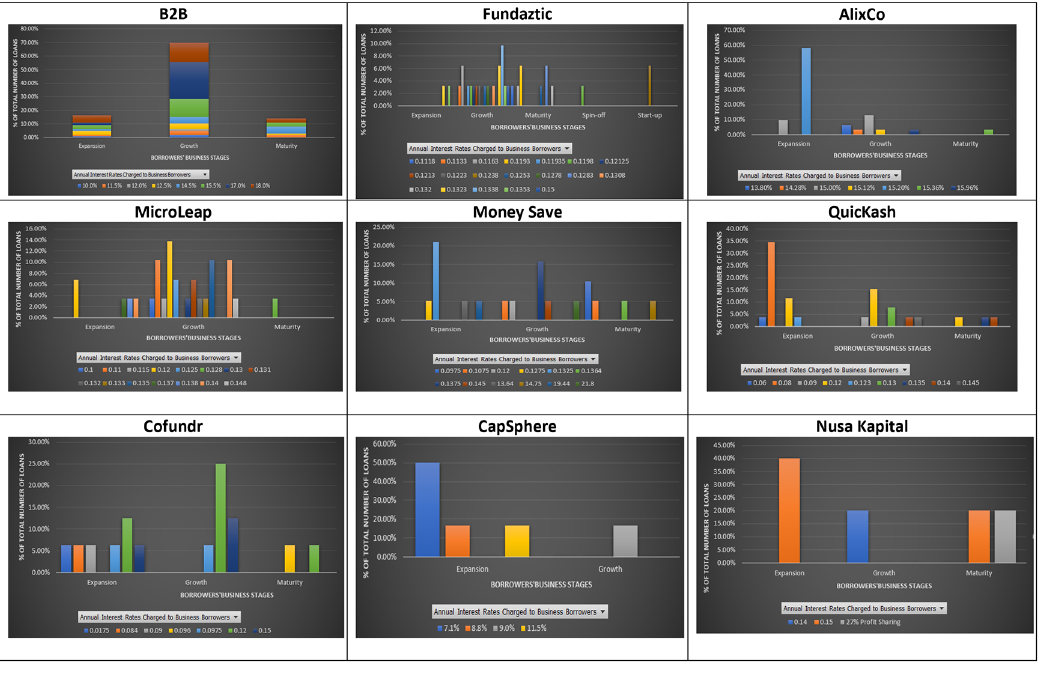
Figure 4. Interest rates and stages of business at nine P2P lending